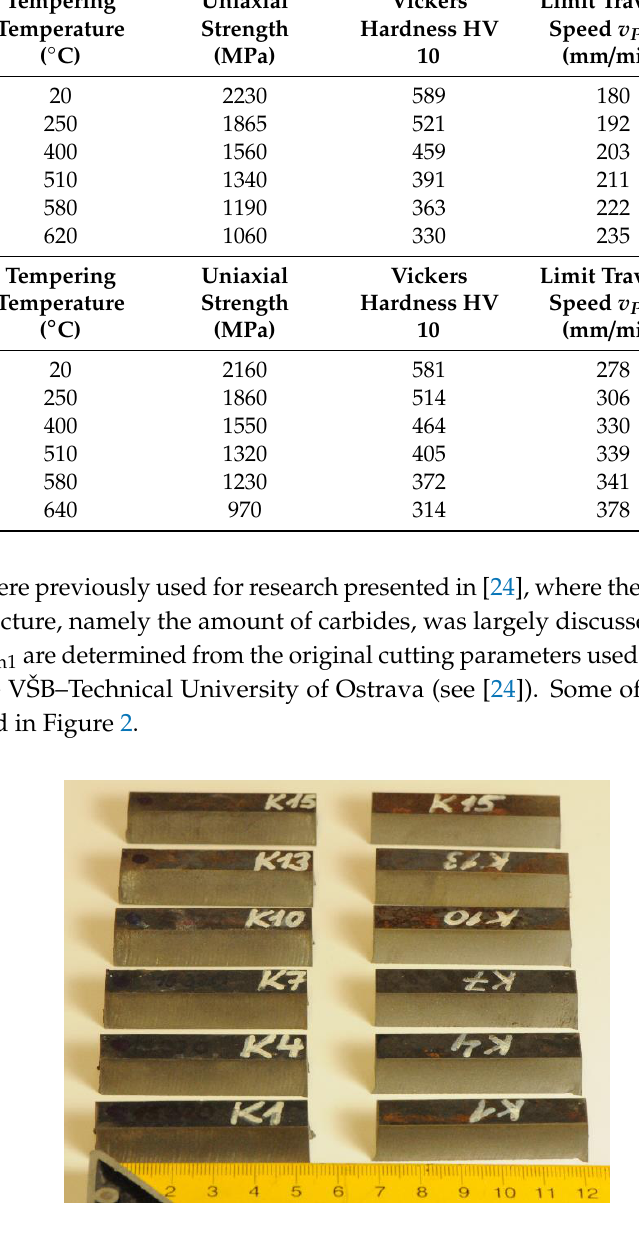
Table 2. Steel 34CrMo4 samples austenitized at 850 °C, quenched in polymer and tempered at various presented temperatures.